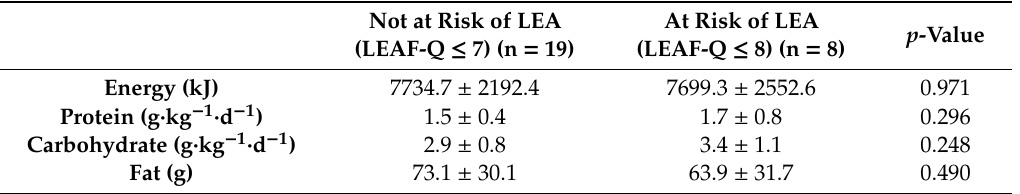
LEA: Low Energy Availability; LEAF-Q: LEA in females